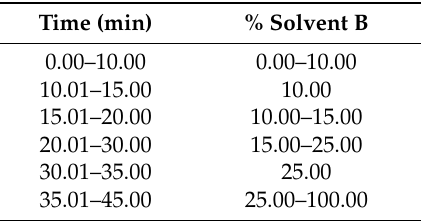
Table 1. The gradient condition of ultra-high-performance liquid chromatography–diode